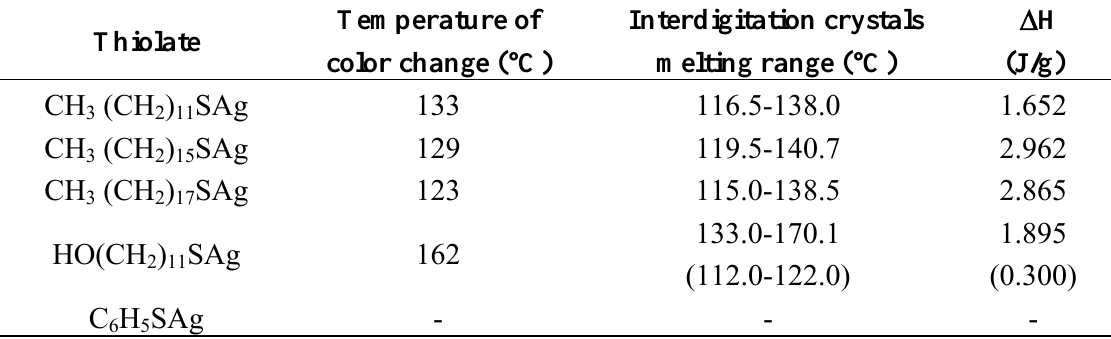
Table 1. Temperature values of color change and thermodynamic properties of reversible thermochromic films obtained by decomposing different silver precursors. The characteristics of the minor endo-thermal peak in the HO(CH given in the brackets.